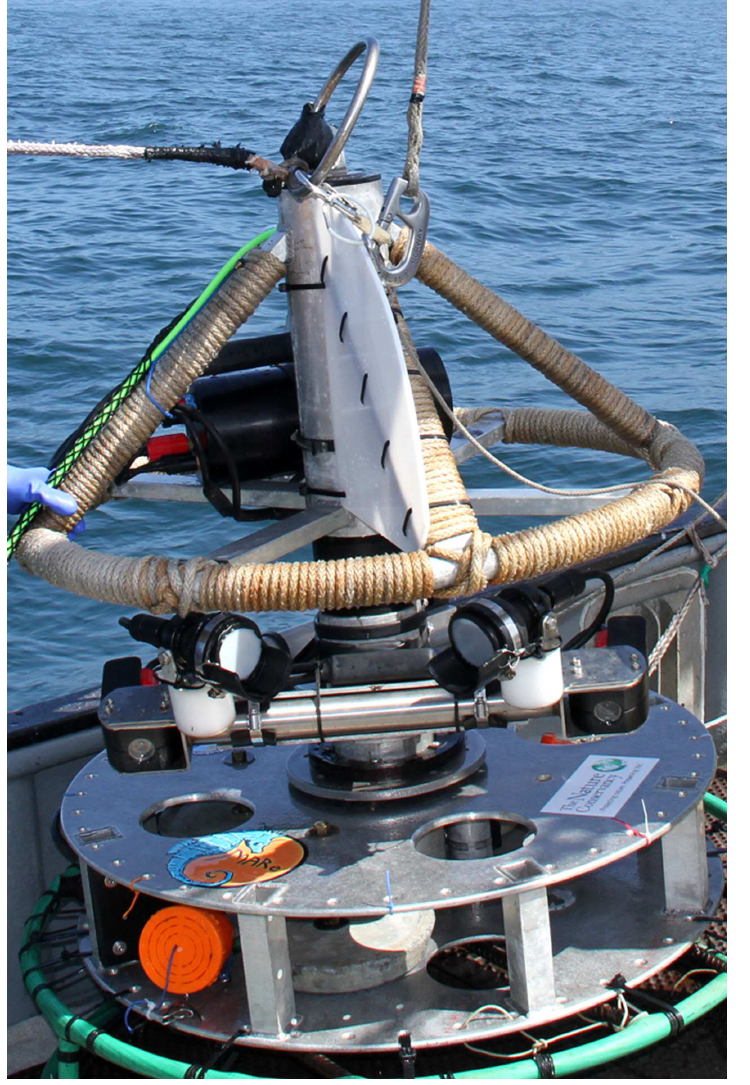
Fig 2. Stereo-video lander used to survey fishes in central California,